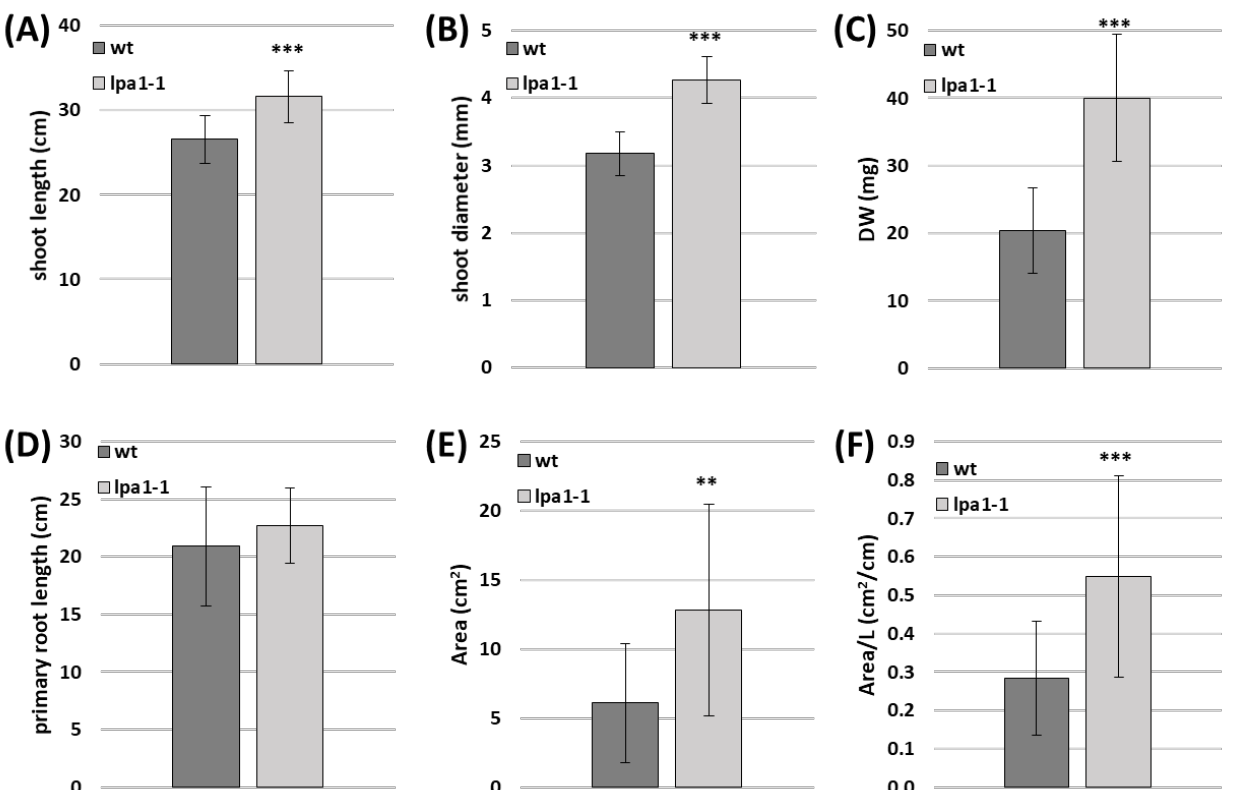
Figure 3. Measurements on the epigeal part of the plant in hydroponics at 16 DAS: shoot length ( A ) and shoot diameter ( B ). Parameters measured on the root system architecture: dry weight, DW ( C ), primary root length ( D ), area occupied by the roots ( E ), and root area per unit of length ( F ). Values represent the mean of twelve biological replicates. Significant differences between wild-type and lpa1-1 were assessed by Student’s t -test (** p < 0.05 and *** p < 0.01).